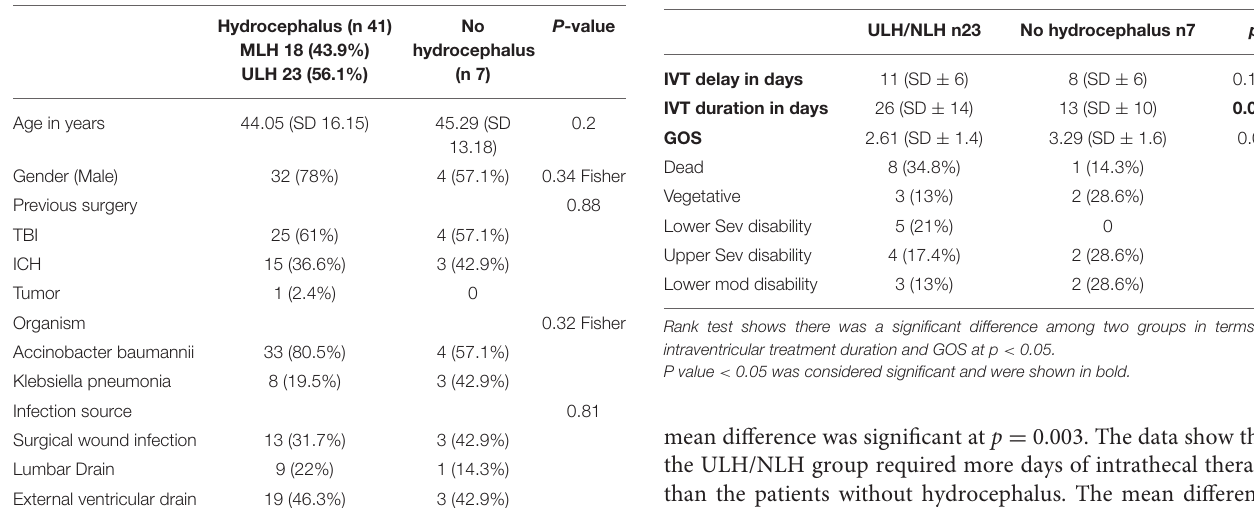
TABLE 3 | Comparison between Uni/non-loculated hydrocephalus (ULH/NLH) vs. with out hydrocephalus in terms of Delay in intraventricular treatment, intraventricular treatment in days, Glasgow outcome score